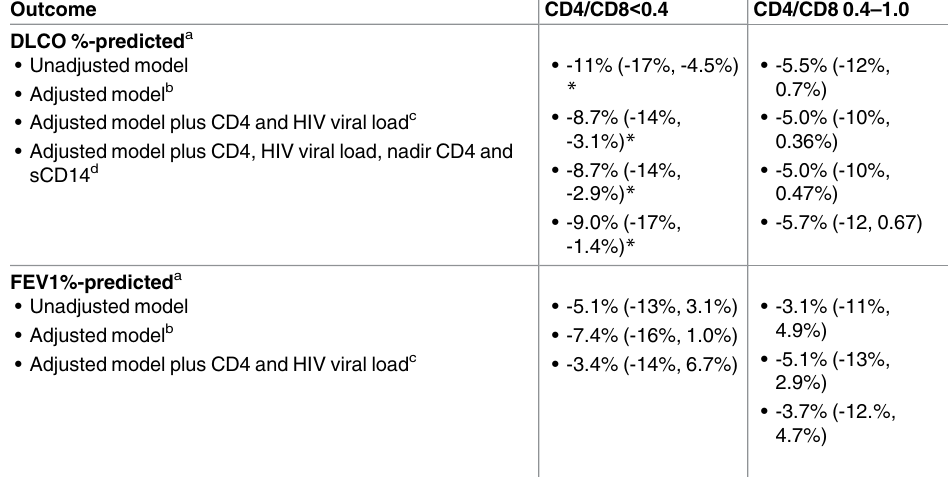
Table 4. Associations between CD4/CD8 ratio categories (relative to ratio > 1.0) with DLCO and FEV1 in linear regression models. Outcome